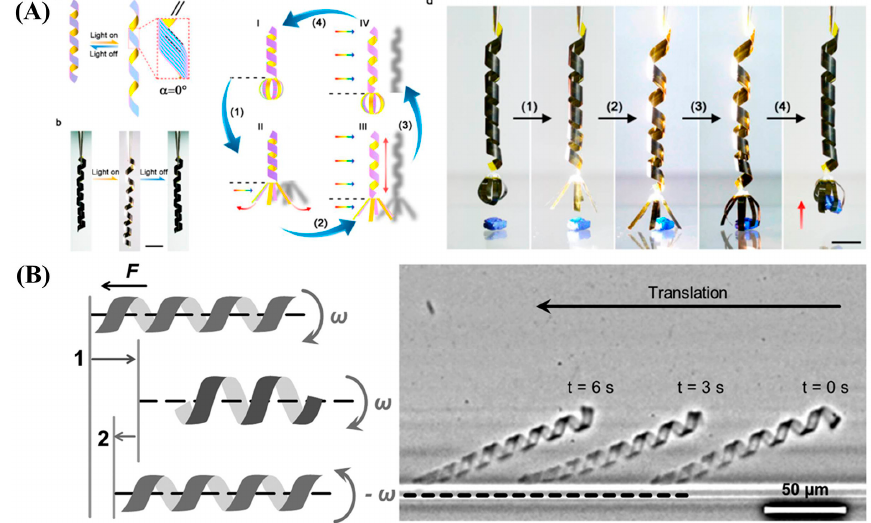
Figure 2. ( A ) Schematic illustration of helical Strip B (a). Photographs of helical Strip B before and after light irradiation (b). Schematic illustration of a mechanical arm completing a catching (releasing) movement (c). (d) Photographs of an object being lifted up by the mechanical arm. Scale bars, 1 cm in (b,d). Reproduced with permission [86]. Copyright 2016, American Chemical Society; ( B ) Illustration of the locomotion generated by non-reciprocal deformations of the helix (left); Directing the rotational motion to a linear translocation when the oscillating helix is confined close to a flat wall that impedes the rotation around the axis normal to the helix direction (right). Reproduced with permission [76]. Copyright 2016, WILEY-VCH.